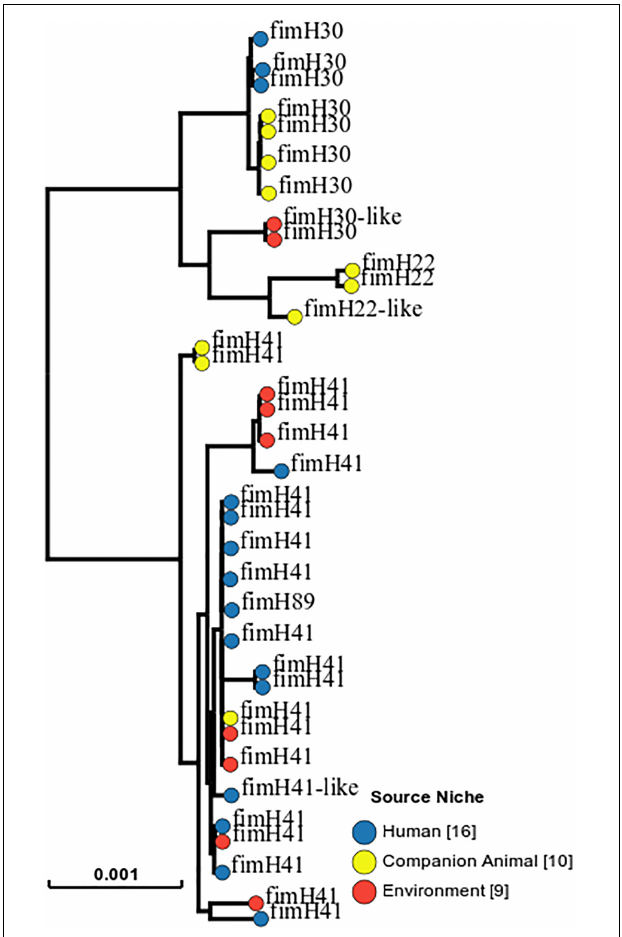
FIGURE 3 | SNP-tree of 35 representative ST131 E. coli genomes collected from human feces ( n = 16), dog feces ( n = 10), and public restrooms ( n = 9). One isolate (No. 13) in an asymptomatic fecal colonization of fimH30 was used as a